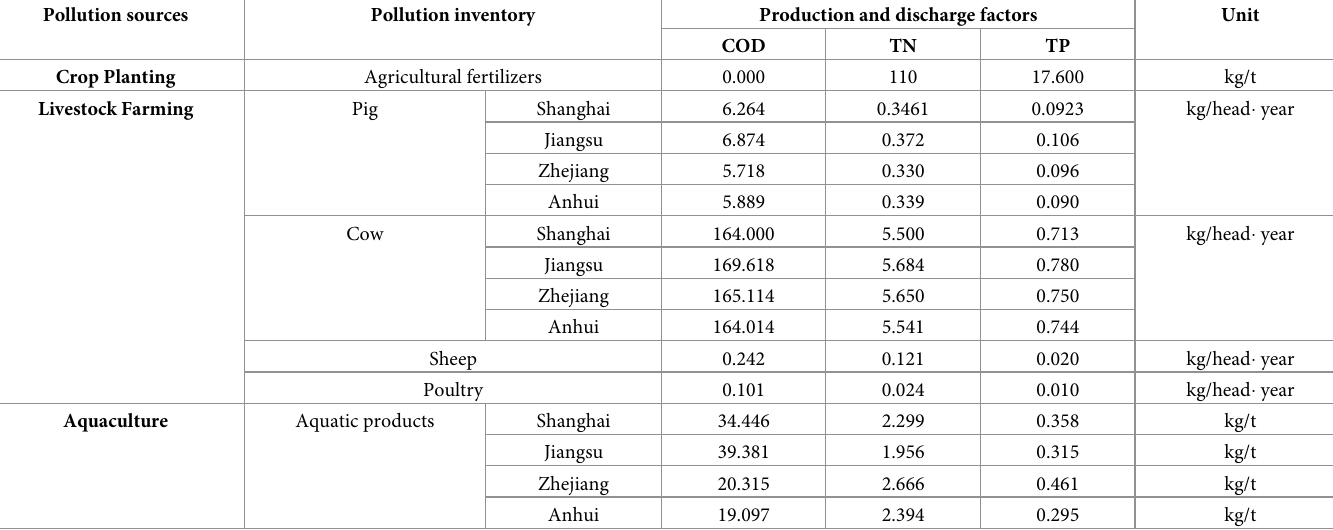
Table 1. Emission factors for each source of agricultural nonpoint source pollution in the YRD.